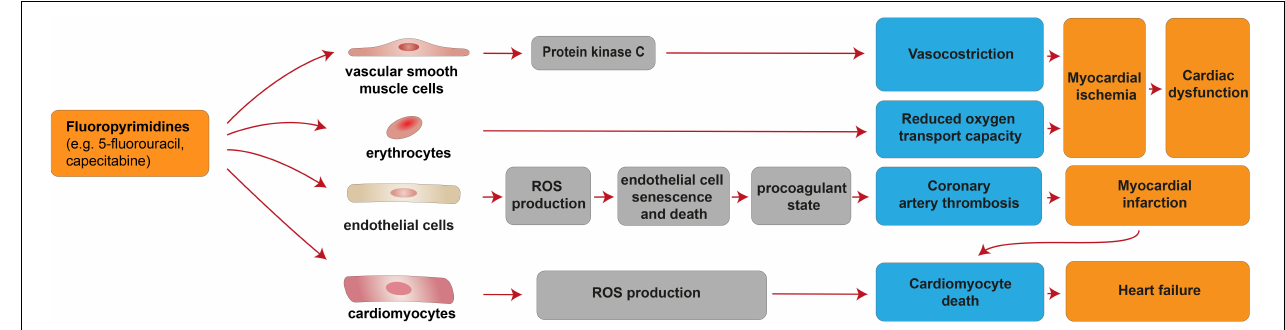
FIGURE 2 | Cellular and molecular mechanisms of the cardiotoxic effects exerted by fluoropyrimidines. Schematic diagram showing the impact of fluoropyrimidines on cardiac dysfunction due to myocardial ischemia induced by deregulation of vascular smooth muscle cells and erythrocytes. Additional mechanisms of taxane-induced cardiotoxicity include heart failure, consequent to cardiomyocyte death induced by cardiomyocyte-intrinsic mechanisms (increased ROS production) or myocardial infarction consequent to coronary artery thrombosis caused by endothelial cell senescence and death.